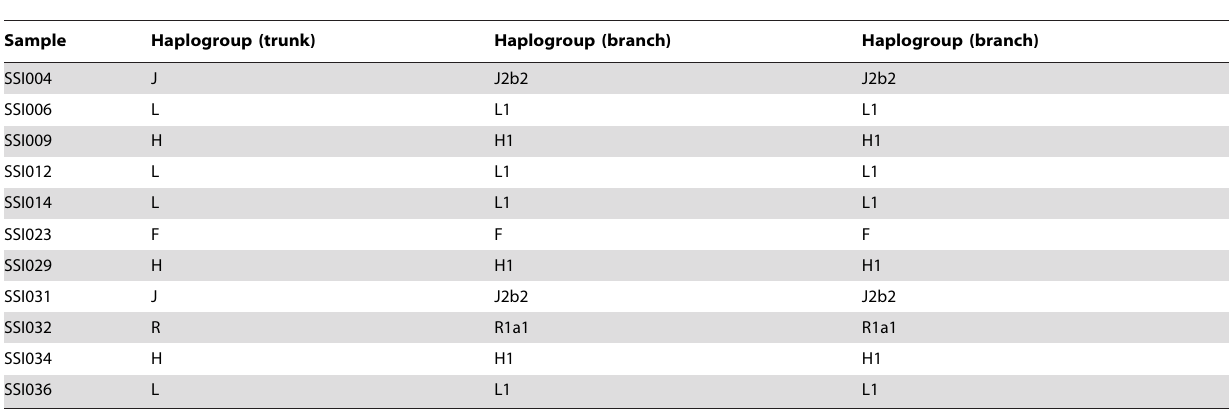
Table 3. Chromosome Y haplogroup assignment for the 11 SSIP male samples.